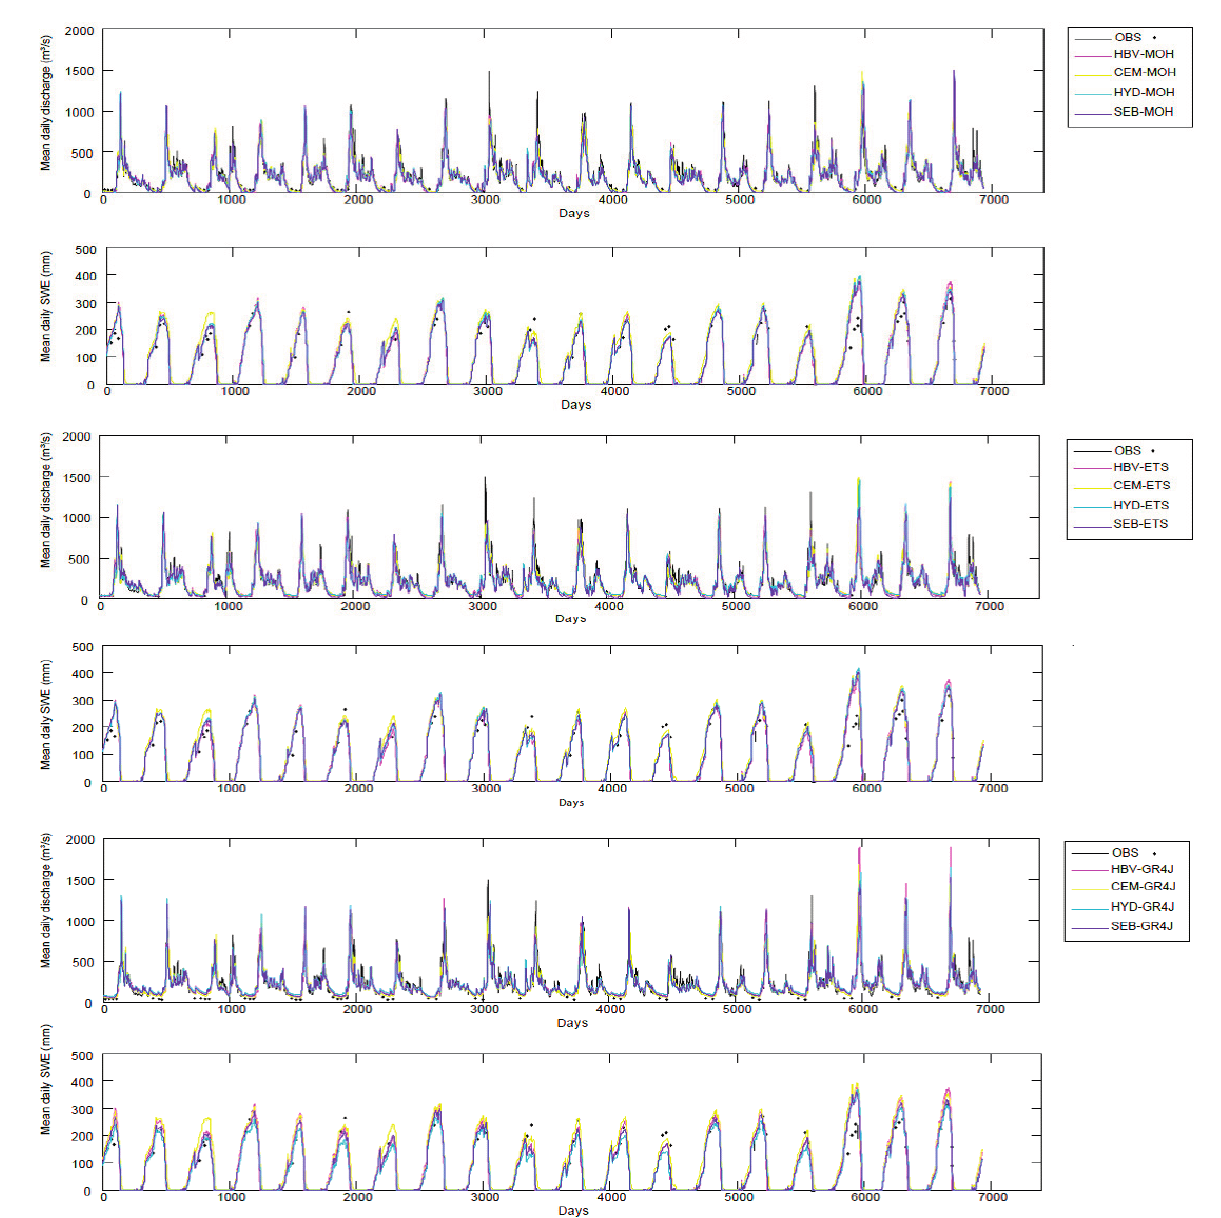
Figure 9. Annual hydrographs of observed (OBS), simulated discharges and SWEs using the 12 SM-HM combinations over the validation period (odd years over